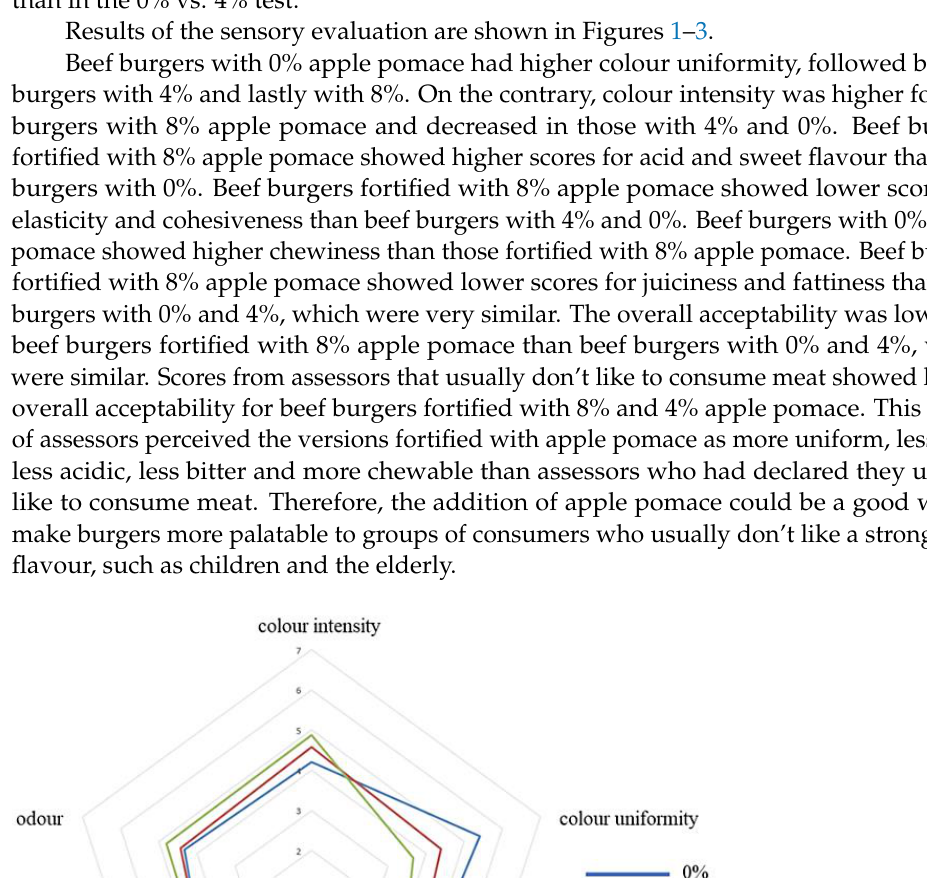
Figure 2. Sensory descriptive analysis. Basic tastes. (0%, control; 4%, burgers added with 4% apple pomace; 8%, burgers added with 8% apple pomace).